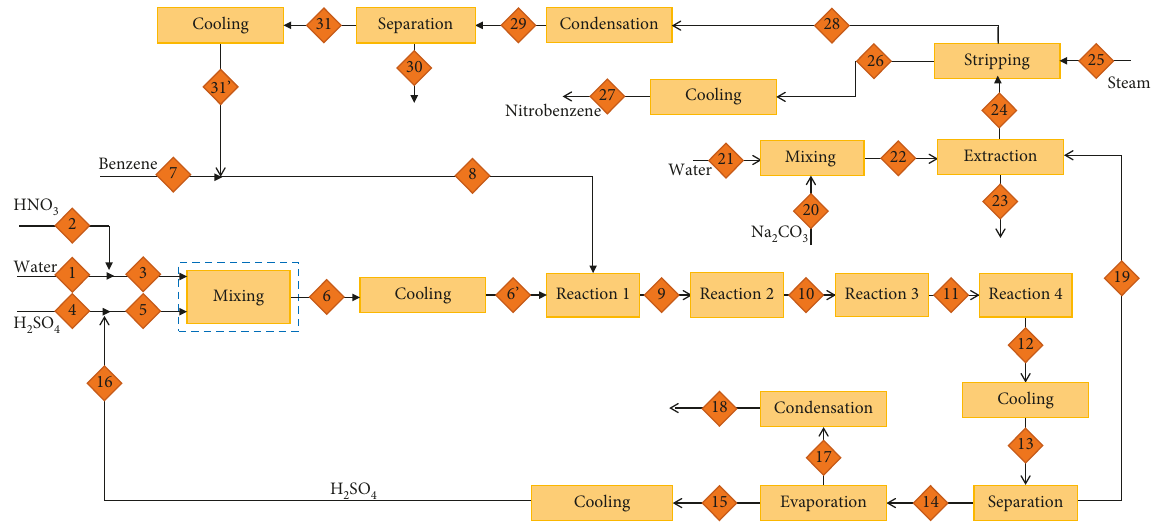
Figure 1: Block diagram of nitrobenzene production via benzene nitration.